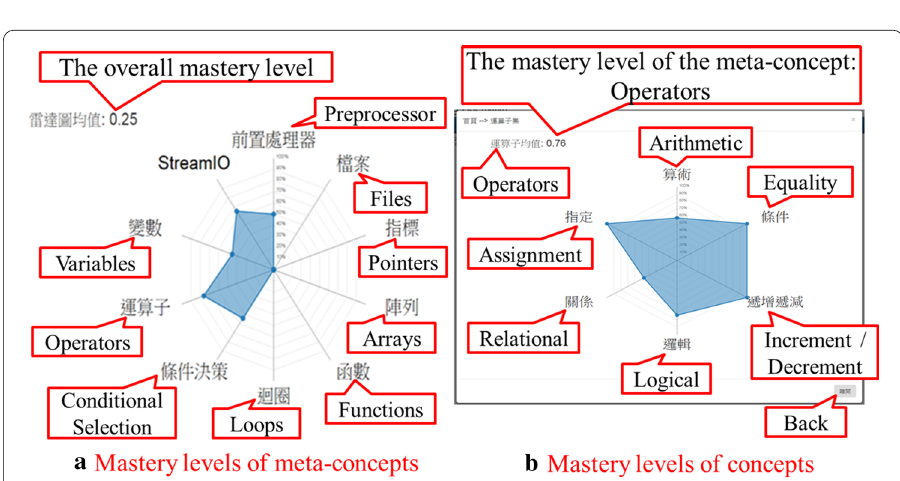
Fig. 8 Open learner model of the mastery levels of meta‑concepts and